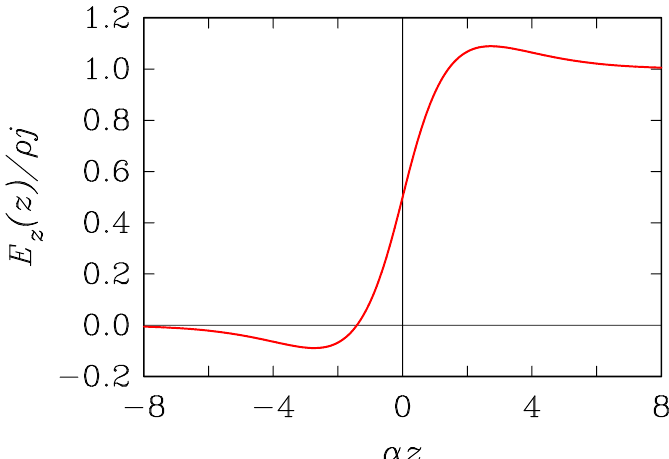
Figure 4. Variation of the electric field predicted by Equation (21) in the effective medium representing a 3D conductive mesh. The upper half space z > 0 is crossed by a uniform current of density j flowing in the z direction. There is no current in the lower half space z <